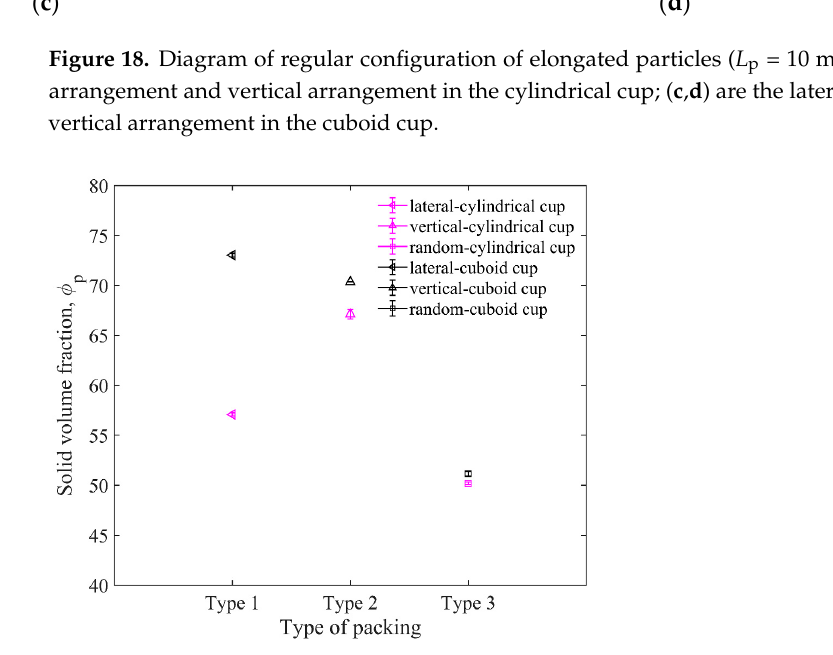
Figure 19. Comparison between solid volume fractions for different packing types (type 1—lateral arrangement, type 2—vertical arrangement, and type 3—random arrangement). The length of particles in the cup is 10 mm.